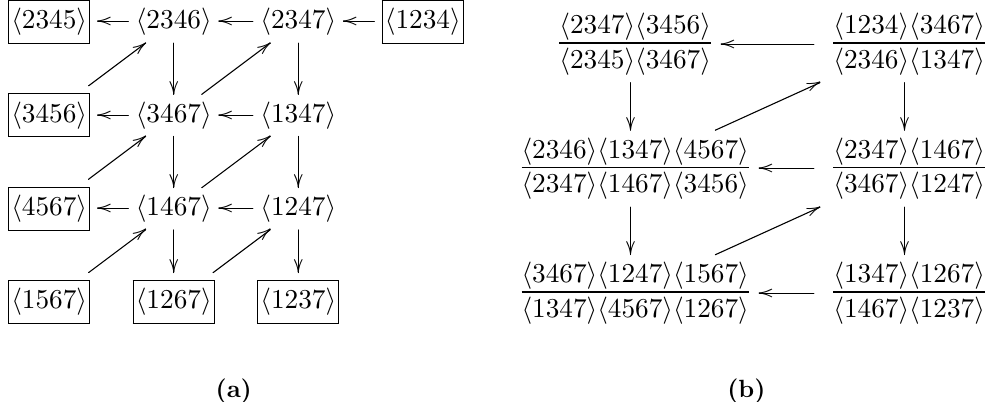
Figure 6. The A -coordinate seed quiver (a) and X -coordinate seed quiver (b) for Gr(4 ;